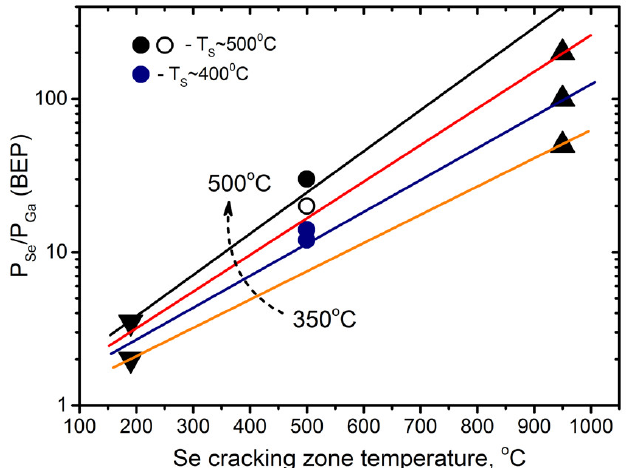
Figure 1. The calculated dependences of the P Se / P Ga (BEP) ratio corresponding to stoichiometric conditions on the GaSe growth surface at di ff erent T S , marked in di ff erent colors (T S = 350 ◦ C, orange; T S = 400 ◦ C, blue; T S = 450 ◦ C, red; and T S = 500 ◦ C, black). The data of Lee et al. [30] are shown by filled triangles with the vertex pointing up (T Se (cr) = 950 ◦ C). The data on P Se / P Ga (BEP) flux ratios corresponding to nearly stoichiometric conditions for GaSe layers growth using standard Ga and Se cells are shown by filled triangles with the vertex pointing down. Our data on P Se / P Ga (BEP) flux ratio for the GaSe layers grown at T S = 400 and 500 ◦ C are shown by blue and black circles, respectively. GaSe layers with and without Ga droplets on the growth surface are indicated by the hollow and filled circles. Table 1. The growth parameters of GaSe / GaAs(001) layers.